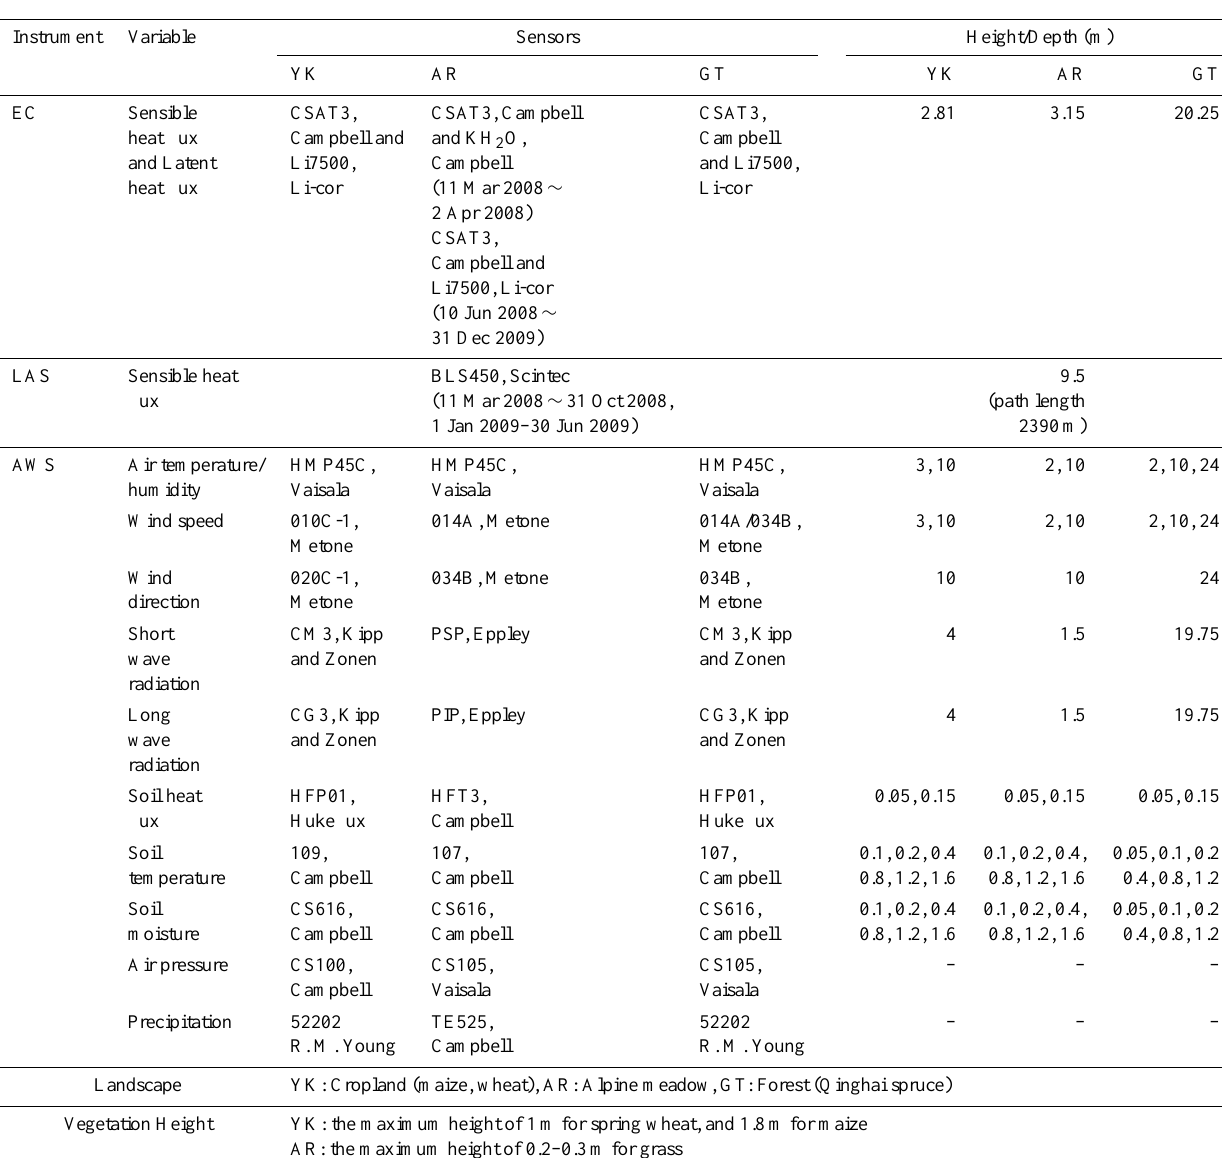
Table 1. Description of the instruments incorporated in the EC, LAS and AWS at each site.